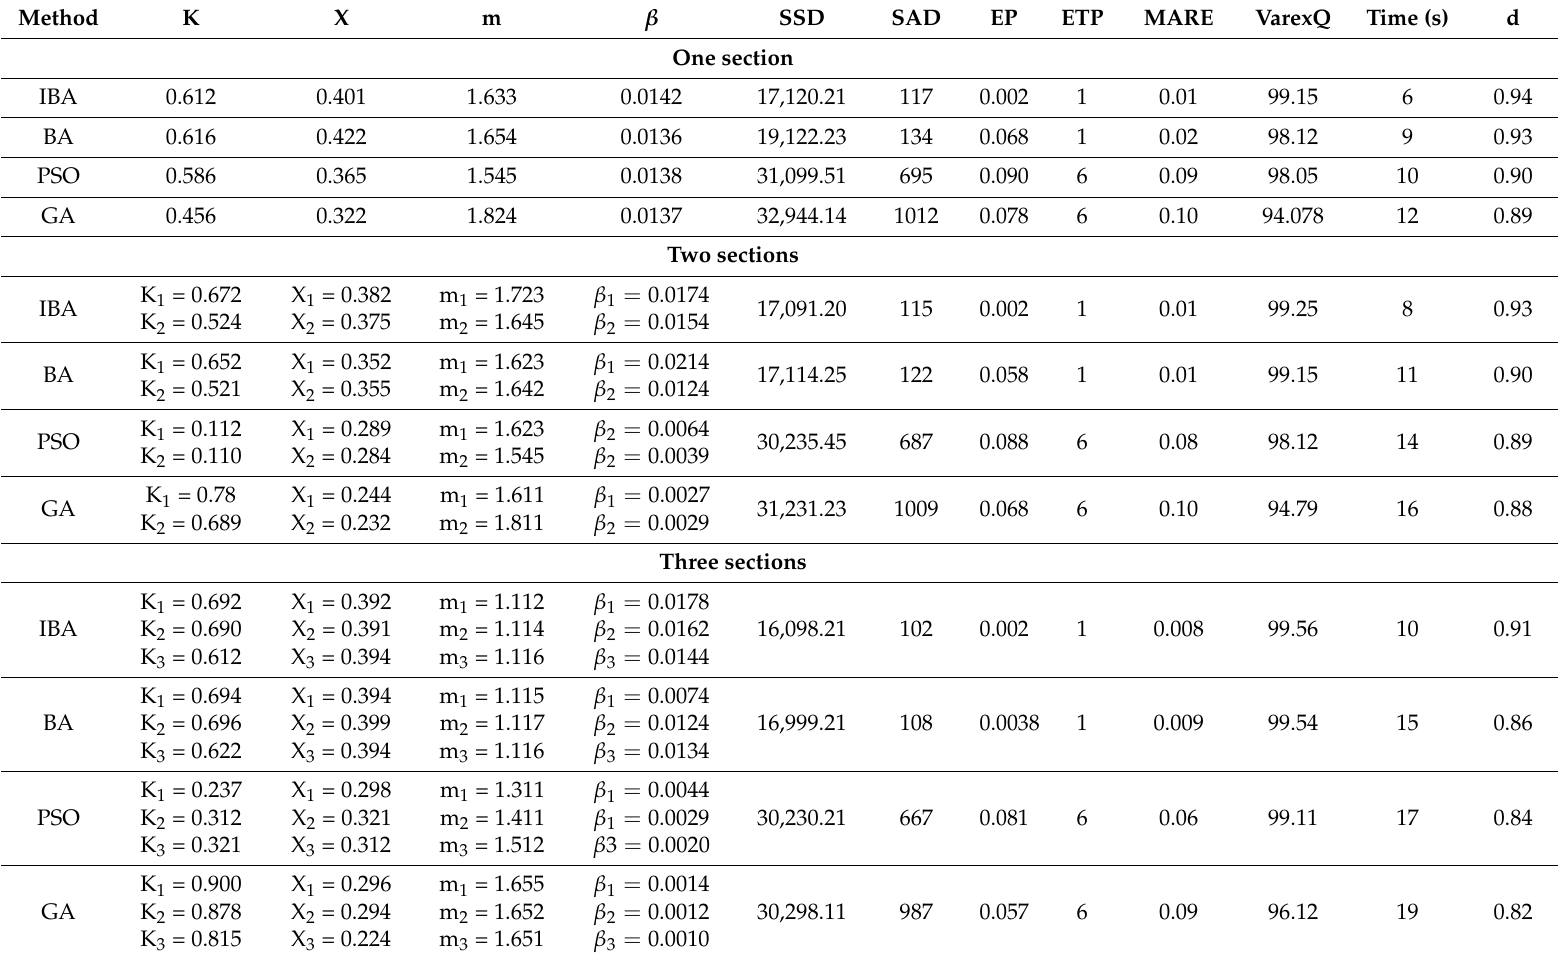
Table 7. Results of four models (i.e., IBA, BA, PSO and GA) for Karahan flood according to three different